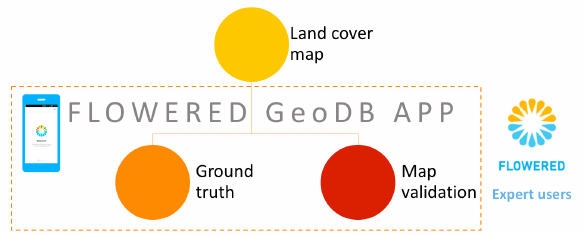
Figure 3. Data collected by expert users.